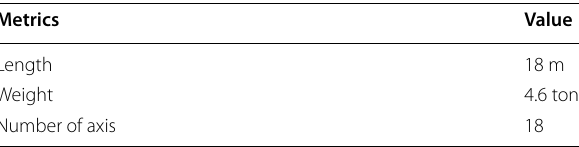
Table 1 Specification of the prototype “Veolia-MHI